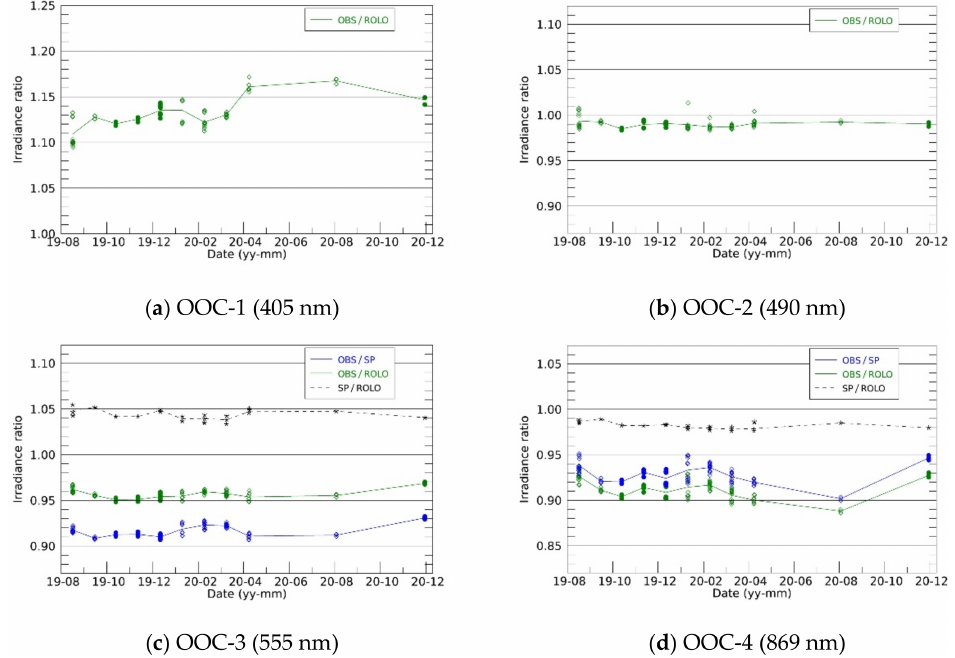
Figure 7. Temporal changes in the observation-to-simulation irradiance ratio (OSR) without the correction of temperature dependence of each sensor (see main text). The ROLO (green) and SP (blue) based OSR, and SP-to-ROLO irradiance ratio (black) are shown in OOC-3 and -4, where the SP model covers the observation wavelength. Waning Moon and waxing Moon are distinguished with filled circles and open diamonds,